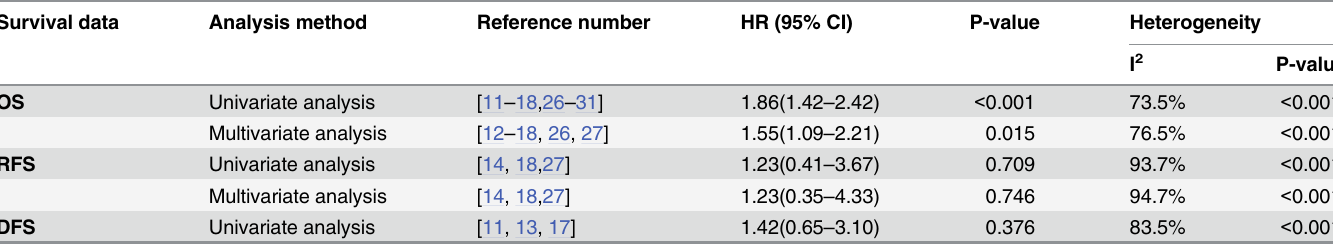
Table 4. Meta-analysis results of decreased LKB1 expression and survival.